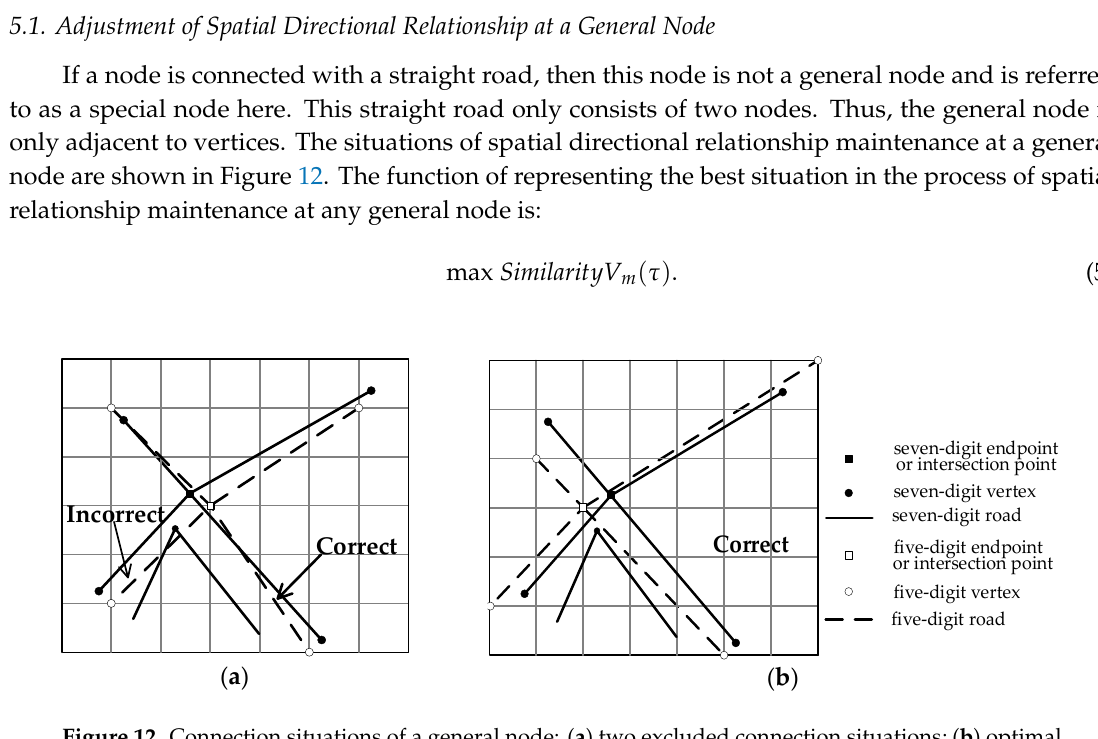
Figure 12. Connection situations of a general node: ( a ) two excluded connection situations; ( b ) optimal connection